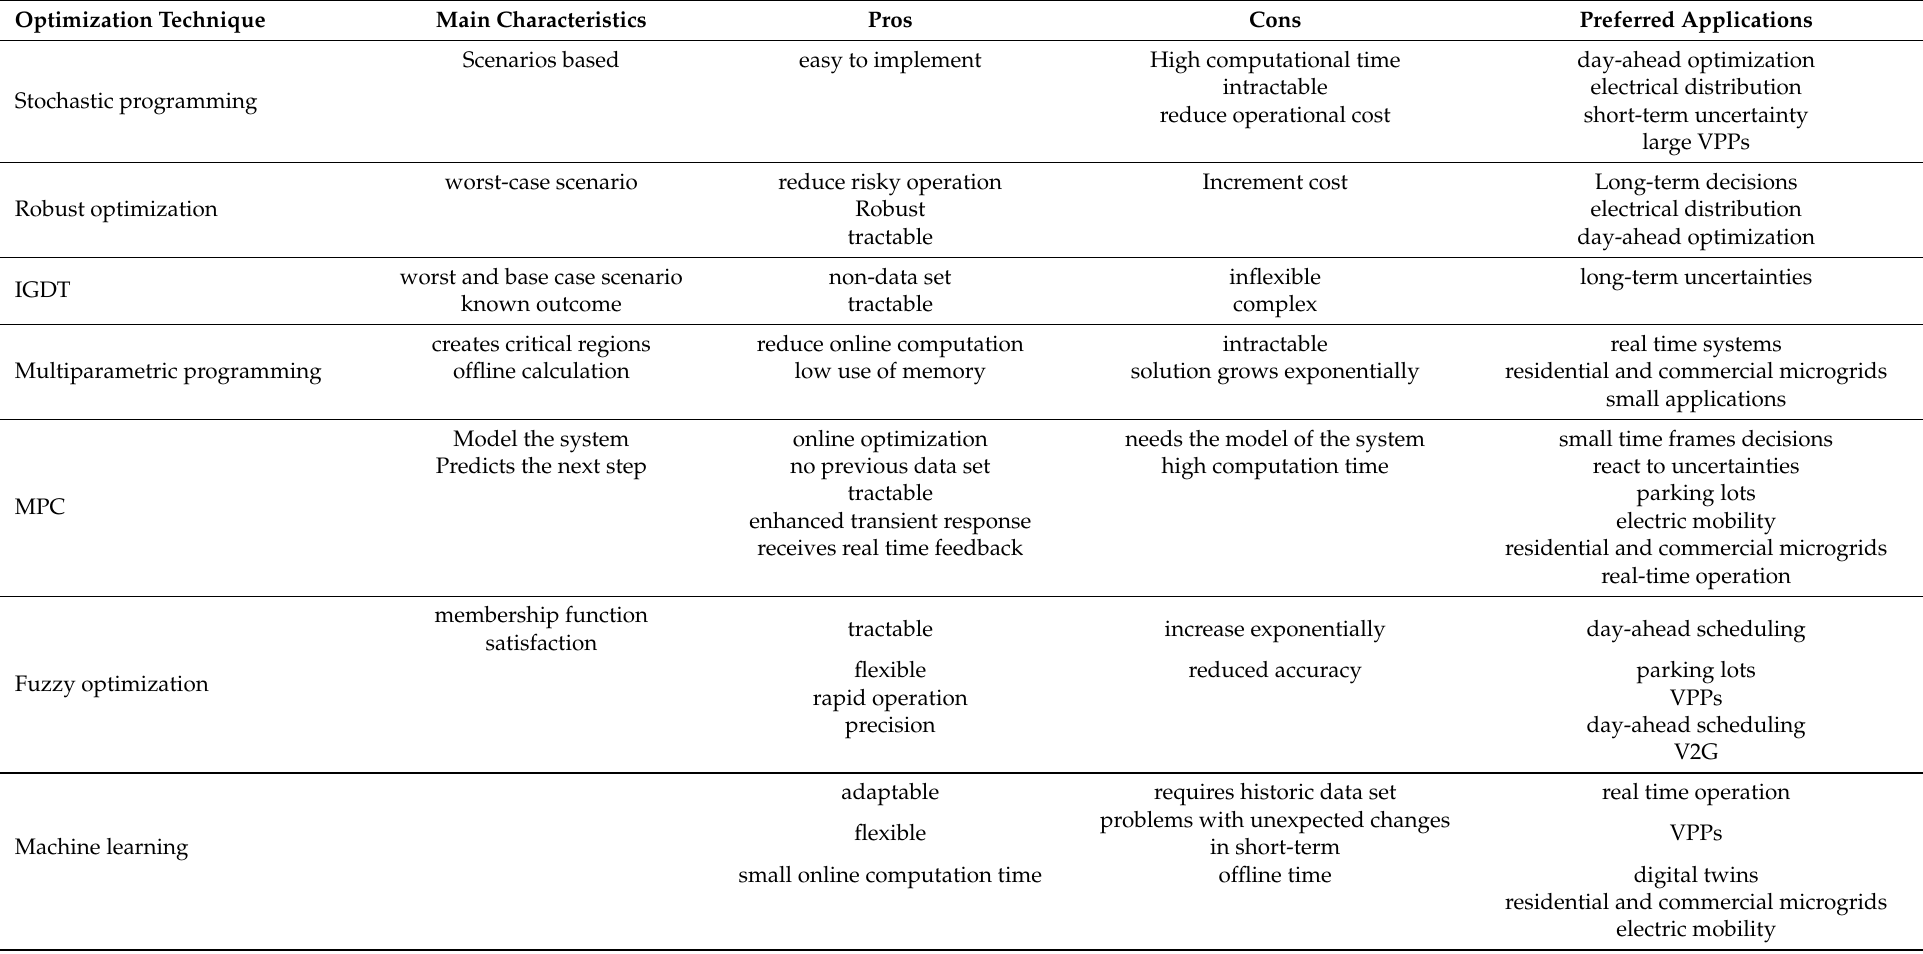
Table 10. Comparison of the optimization techniques for microgrids under